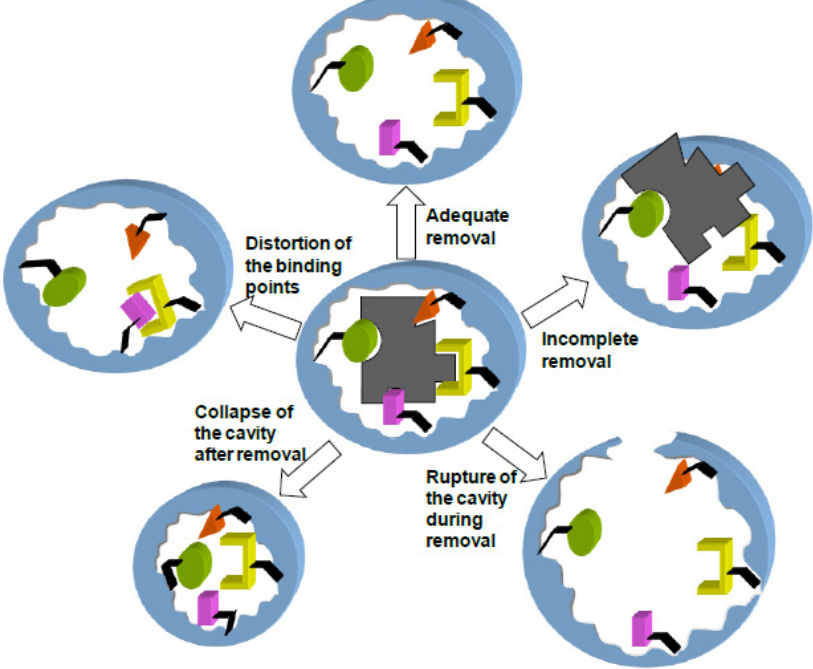
Figure 3. Example for the synthesis of MIP for capturing/binding dye molecules. Reproduced with permission from Rosa A. Lorenzo [50], published by MDPI AG,